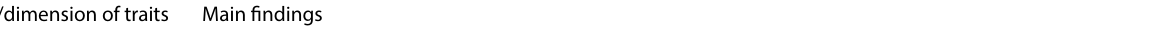
Table 3 Summary of